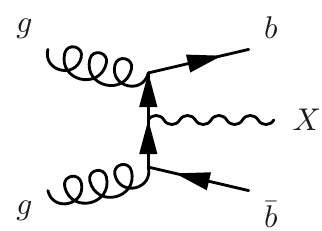
Figure 7. Dominant X production mode at the LHC for m X at the TeV